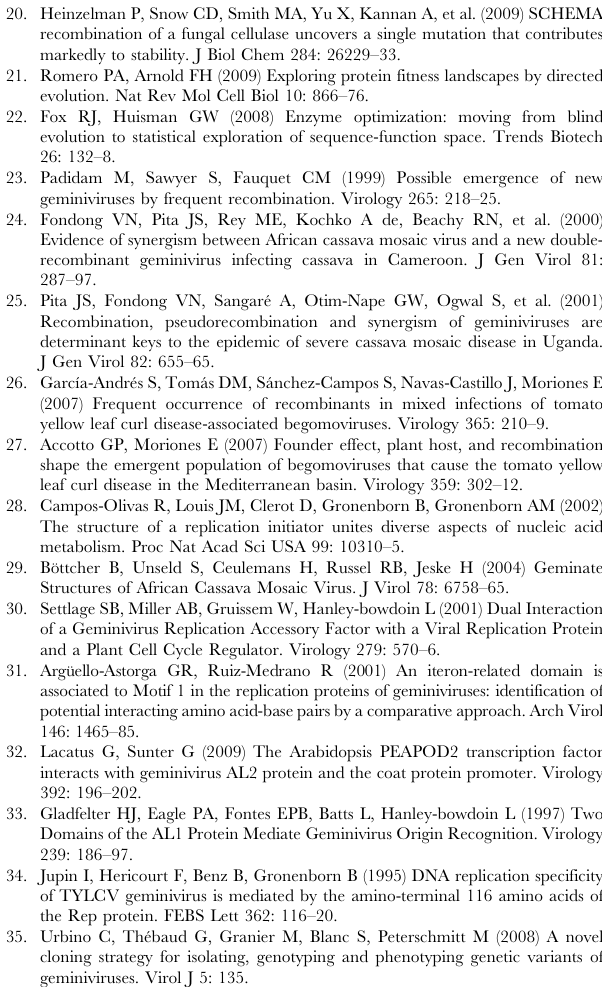
Figure S1 Schematic representation of the methodology used to detect associations between polymorphic nucleotide sites within the TYX and TOX derived recombinant genomes associations in the recombinant alignment. Figure S2 The distribution of recombination breakpoints detected within the 114 recombinant sequences emerging during Tomato yellow leaf curl virus (TYX) and Tomato leaf curl Comoros virus (TOX) co-infections. All detectable unique breakpoint positions are indicated by small vertical lines at the top of the graph. A 50 (panel A), 75 (panel B), 100 (panel C) and 200 (panel D) nucleotide window was moved along the alignment one nucleotide at a time and the number of breakpoints detected within the window region was counted and plotted (solid line). The upper and lower broken lines respectively indicate 99% and 95% confidence thresholds for globally significant breakpoint clusters. Light and dark grey areas respectively indicate the expected 99 and 95 percentiles of expected recombination breakpoint clustering assuming random recombination. Whereas red areas indicate recombination hot-